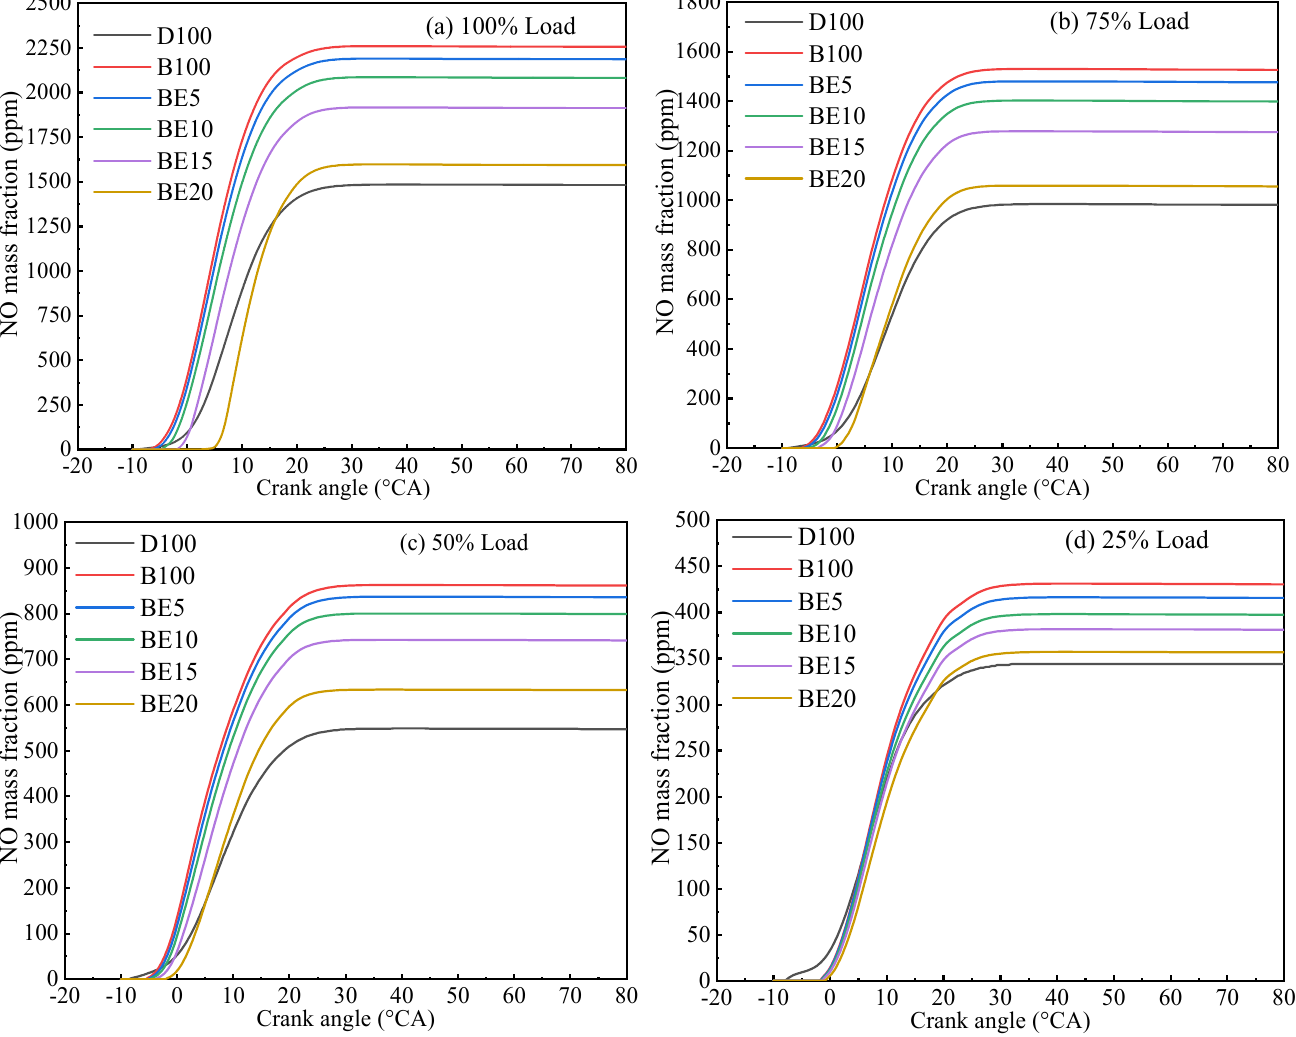
Figure 14. Comparison of NO x emission for different blended fuels at different loads. ( a ) 100% Load, ( b ) 75% Load, ( c ) 50% Load, ( d ) 25% Table 6. NO x mass fraction distribution field in the cylinder at 100% load.